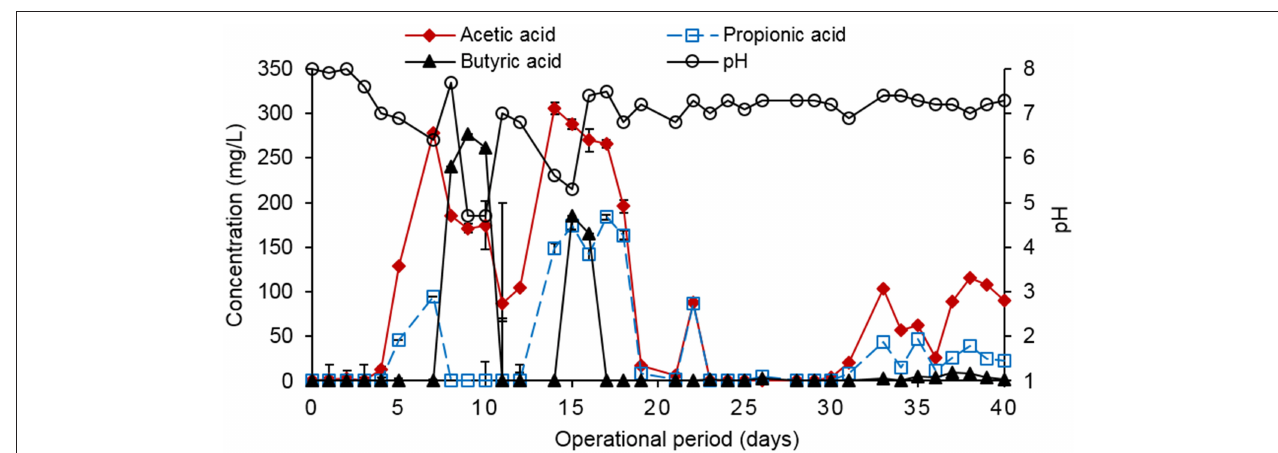
FIGURE 10 | VFA production in the UASB reactor amended with biochar.